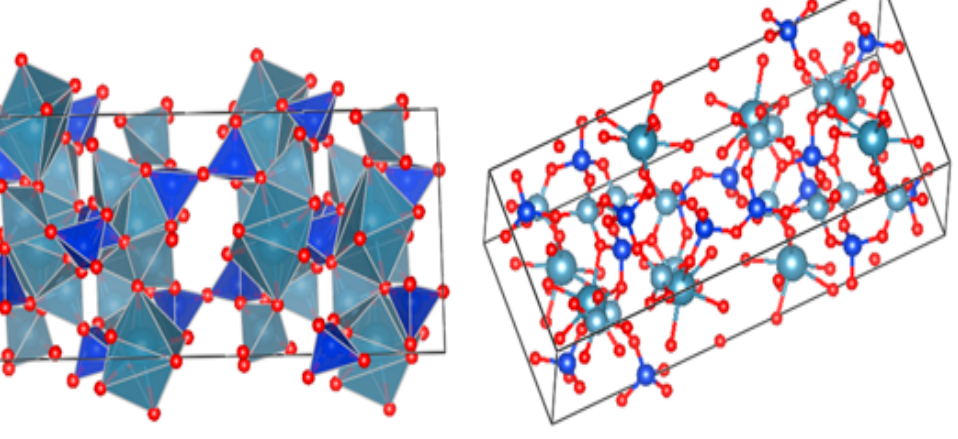
Figure 1. The crystal structure of gismondine (Ca 2 Al 4 Si 4 O 16 .9H 2 O).